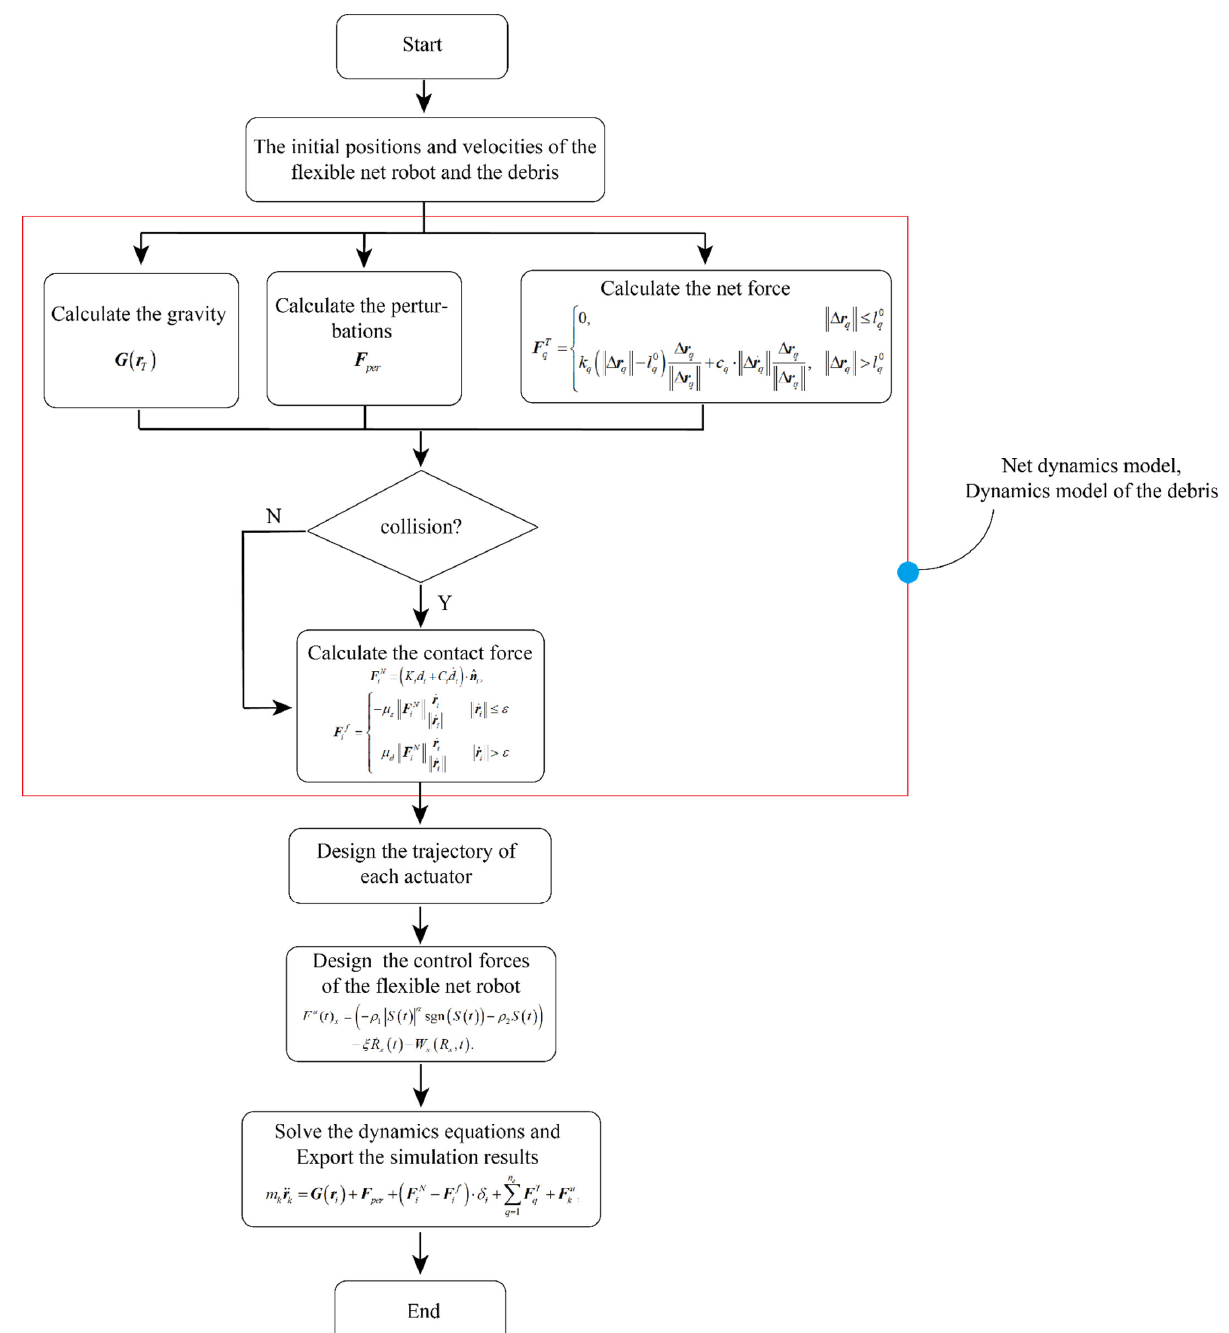
Figure 1. Flowchart of the presented capture dynamics